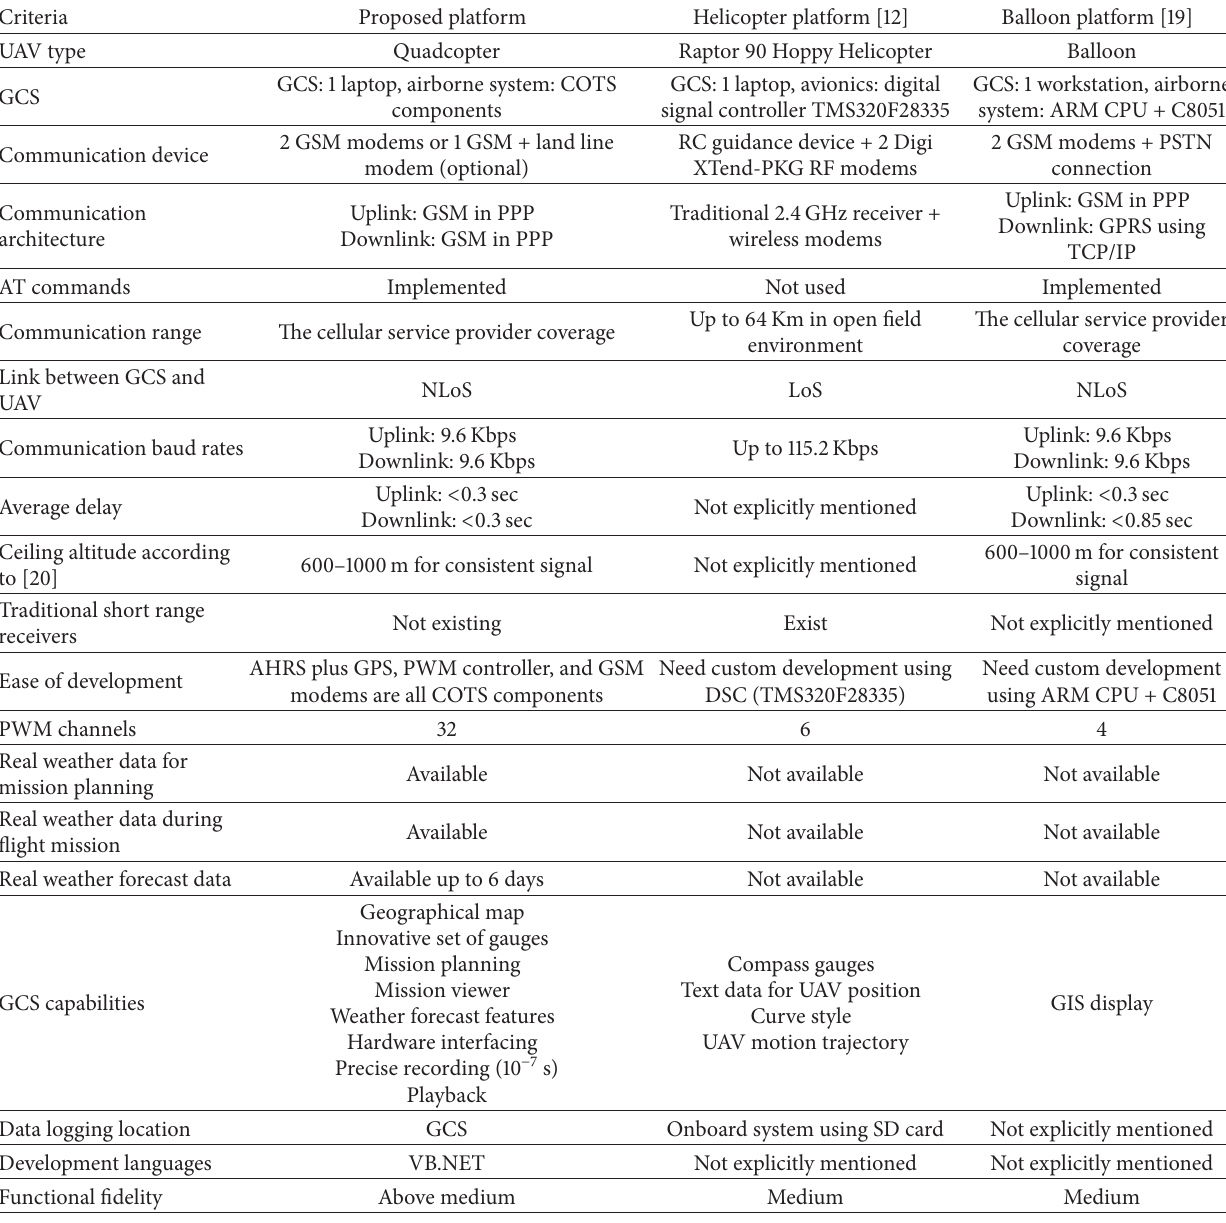
Table 4: Proposed GSM based UAV platform versus other different existing platforms (see Figure 21).